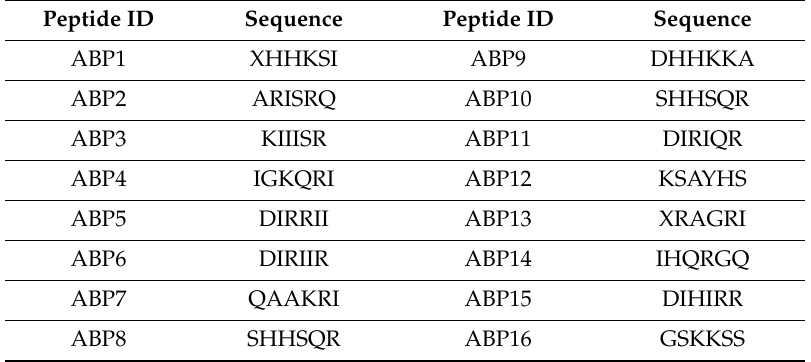
Table 1. Sequences of 16 a ffi body-binding linear peptides discovered via library screening. The “X” denotes an amino acid that could not be assigned via MS / MS sequencing.